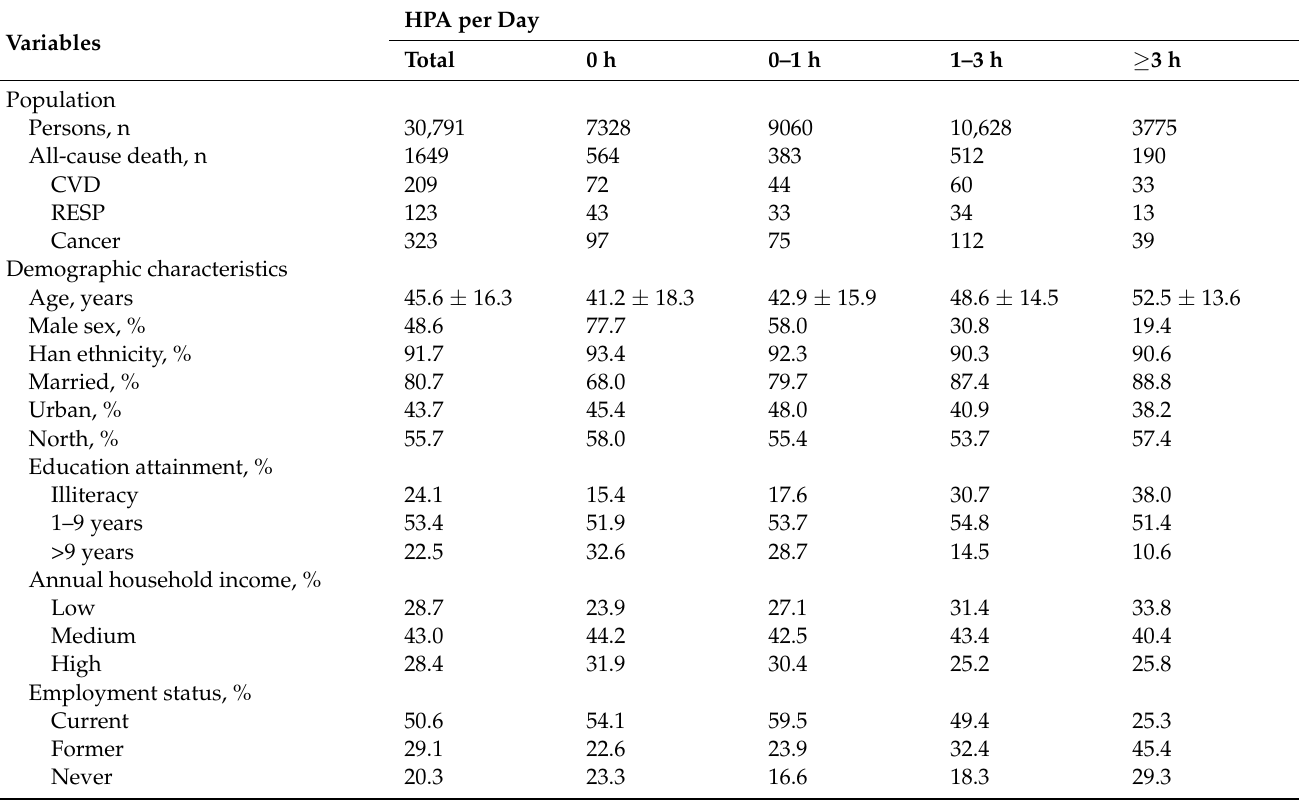
Table 2. Baseline characteristics of included participants (n = 30,791) by